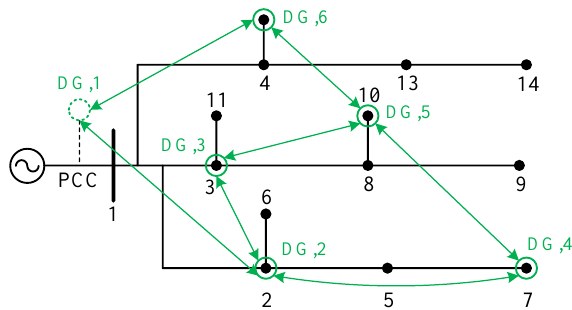
Figure 2. Topology of the simulation system and communication network. Table 1. Parameters of DGs in IEEE-14.